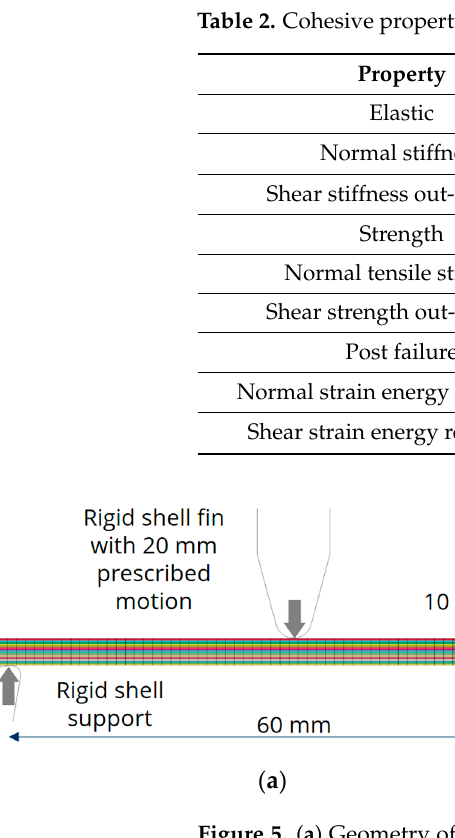
Figure 5. ( a ) Geometry of three-point bending test. ( b ) Force–displacement curve with according energies.